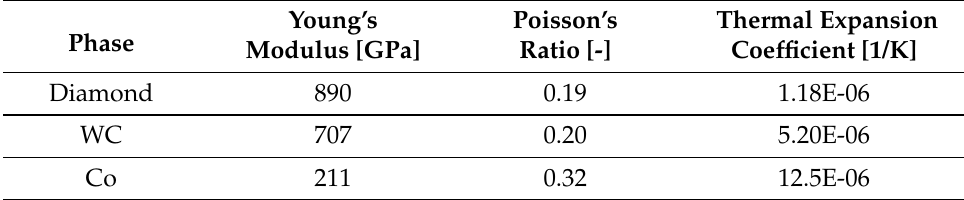
Table 2. Material parameters for the diamond, the WC phase and Co matrix